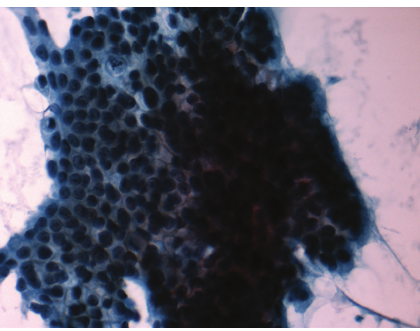
Figure 4: Histological findings of the clavicle biopsy showing metastases pancreatic